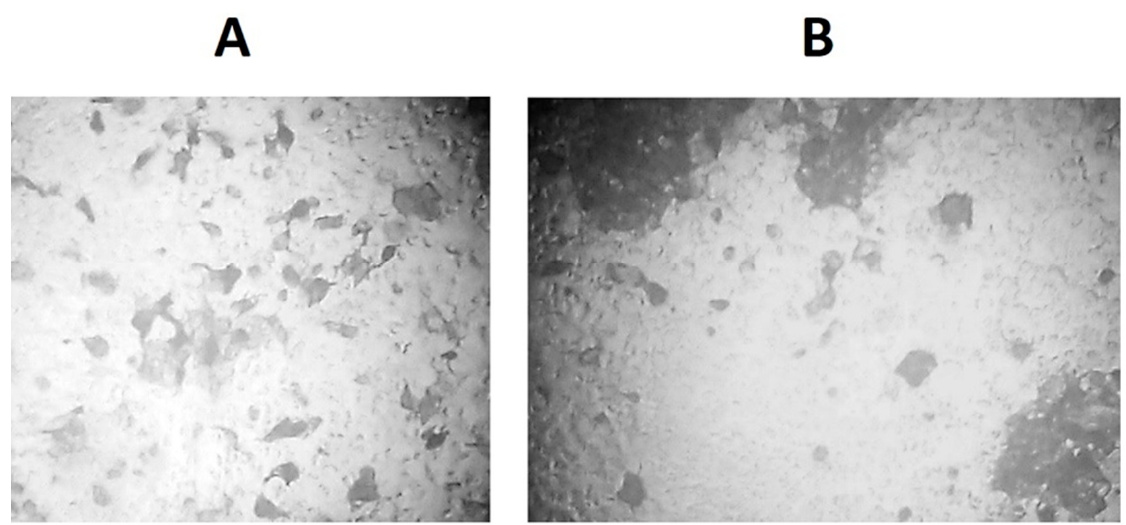
Figure 7. Different pictures of cells infected with R5p ( A ) and R6p ( B ) variants of influenza virus Rostock.